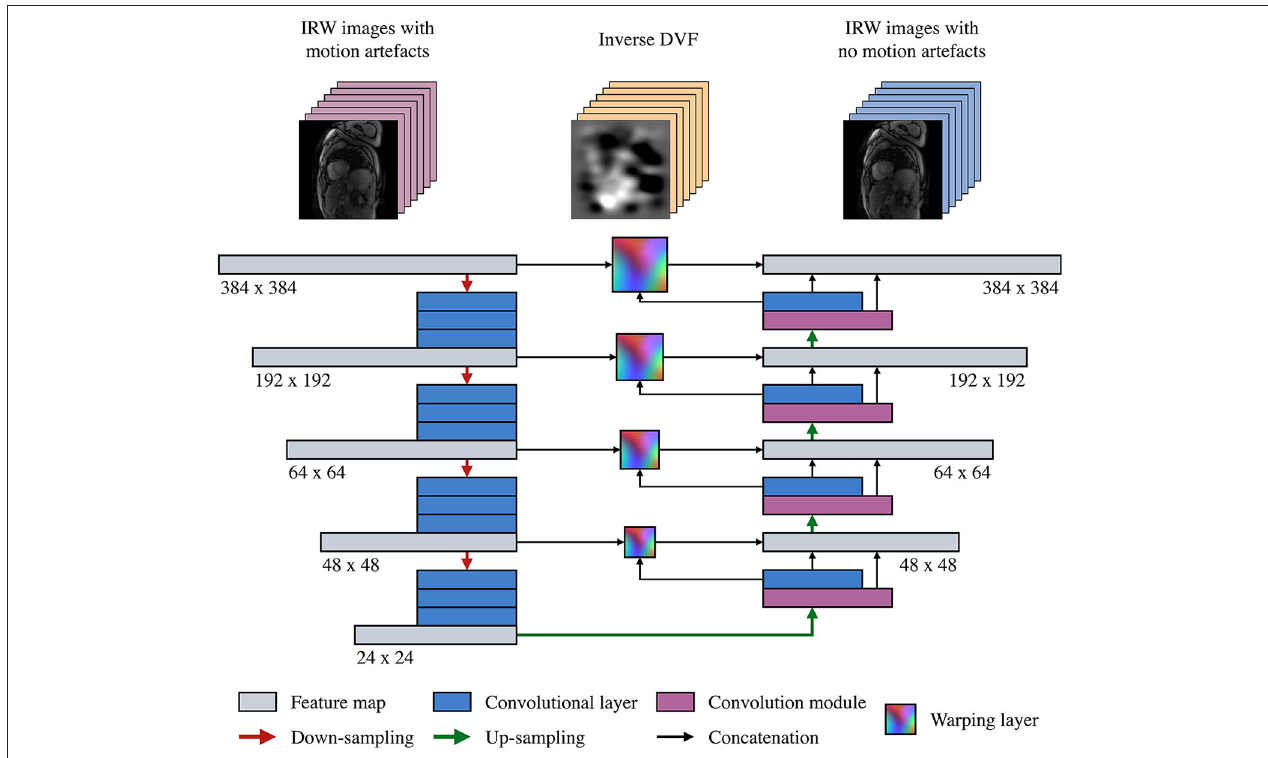
FIGURE 2 | Structure of the proposed motion correction convolutional neural network (MOCOnet). A stack of seven inversion recovery-weighted (IRW) images is input into the encoder-decoder structure on a per-channel basis. The warping layers estimate the optical flow from all the channels in a coarse-to-fine manner at each scale. The last warping layer generates the inverse distance vector field (DVF), i.e., the deformation required to correct the motion artefacts, in a groupwise